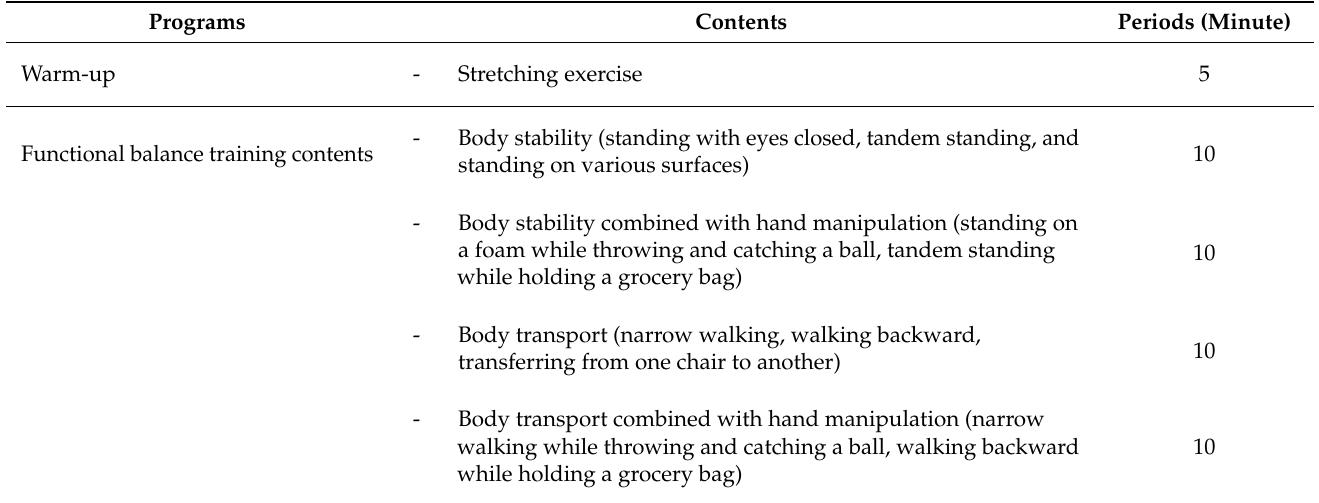
Table 2. Balance training